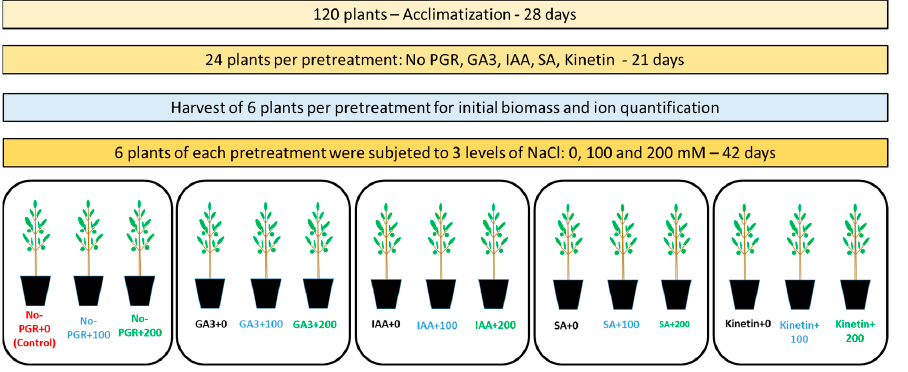
Figure 1. Schematization of the experiment. Non-pretreated plants with no NaCl (No-PGR; control); non-pretreated plants with 100 mM NaCl (No-PGR+100); non-pretreated plants with 200 mM NaCl (No-PGR+200); pretreated with gibberelic acid and no NaCl (GA 3 +0); pretreated with gibberelic acid and with 100 mM NaCl (GA 3 +100); pretreated with gibberelic acid and with 200 mM NaCl (GA 3 +200); pretreated with indol-3-acetic acid and no NaCl (IAA+0); pretreated with indol-3-acetic acid and with 100 mM NaCl (IAA+100); pretreated with indol-3-acetic acid and with 200 mM NaCl (IAA+200); pretreated with salicylic acid and no NaCl (SA+0); pretreated with salicylic acid and with 100 mM NaCl (SA+100); pretreated with salicylic acid and with 200 mM NaCl (SA+200); pretreated with Kinetin and no NaCl (Kinetin+0); pretreated with Kinetin and with 100 mM NaCl (Ki- netin+100); pretreated with Kinetin and with 200 mM NaCl (Kinetin+200). The dry weight of roots, stems, and leaves, Na + and K + levels, Na + /K + ratio, and the net translocation rates of these ions to the leaves of olive plantlets were analyzed. We also evaluated the leaf relative water content, photosynthetic pigments, proline, alcohol-solu- ble sugars, sugar alcohols, starch, free polyamines, and ethylene in leaves given that the highest metabolite concentrations were found in this organ.